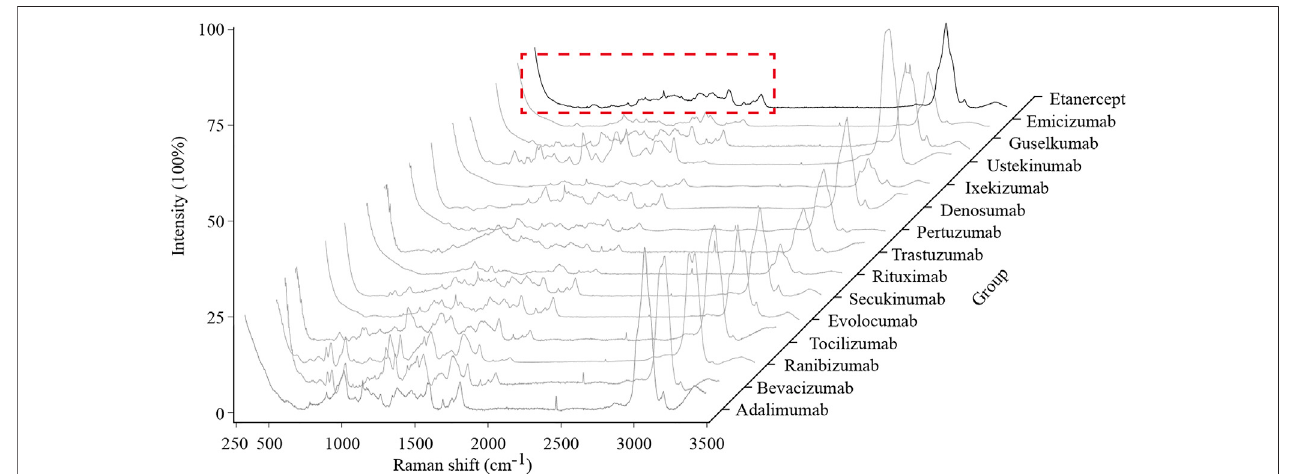
FIGURE 3 | Typical Raman spectra of the 15 therapeutic mAbs. The characteristic region of the Raman spectrum is marked with a red dashed line